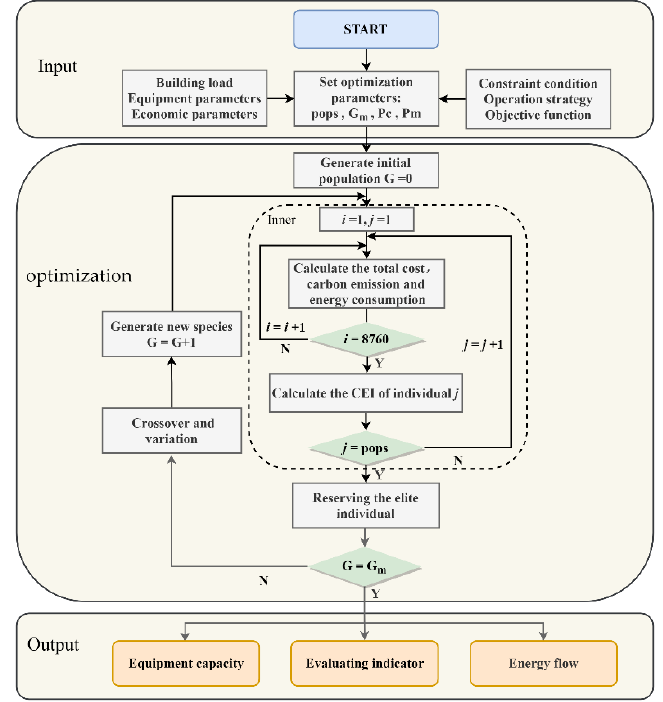
Figure 2. The flow chart of the optimization model.